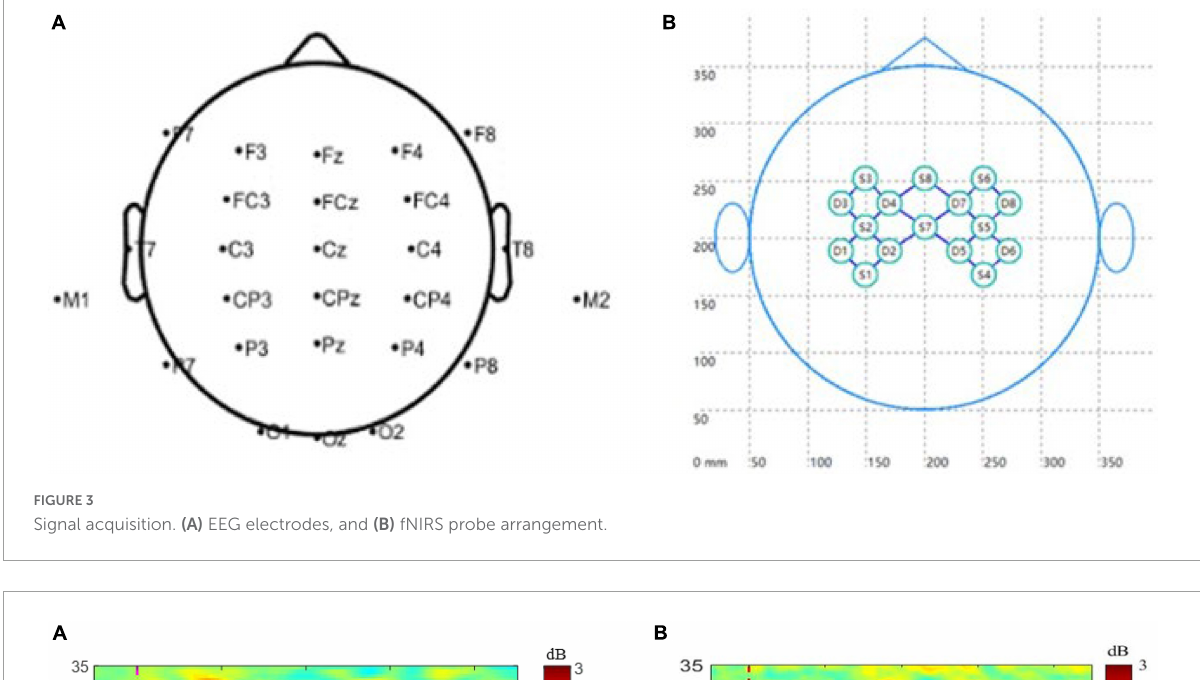
FIGURE3 Signal acquisition. (A) EEG electrodes, and (B) fNIRS probe arrangement.